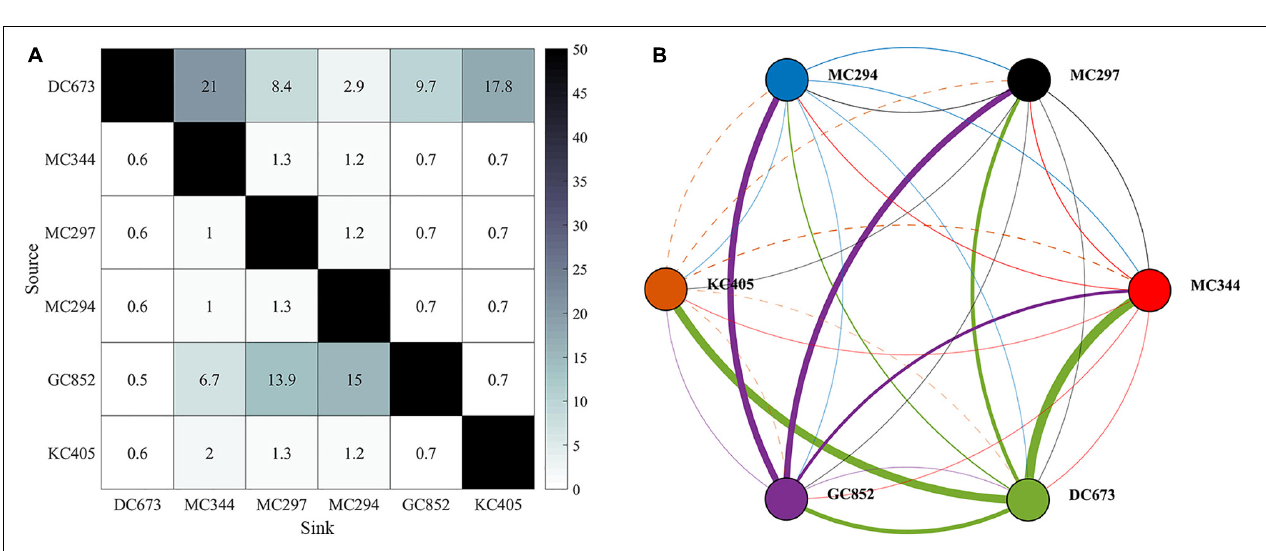
FIGURE 3 | Relative vorticity near bottom in February (A) , May (B) , August (C) , and November (D) calculated from model simulation. Negative values are anticyclonic or clockwise rotation. Panels (E,F) are the zoom-in regions between 93–90 ◦ W, 26.2–27.7 ◦ N in August (C) and November (D) . Red box with black edge shows the location of GC852.